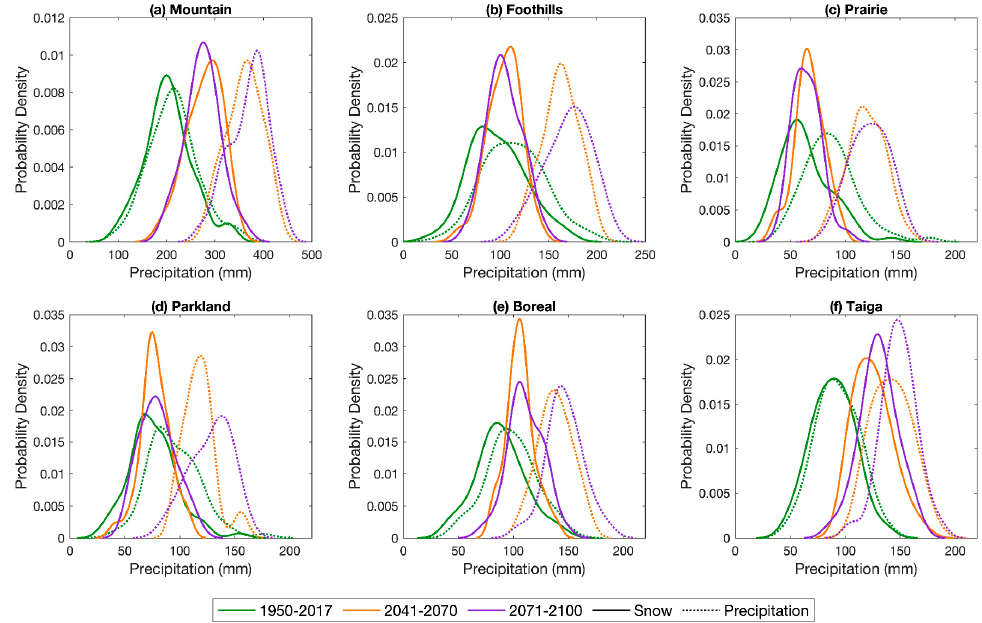
Figure 11. Probability density function of total November–April snowfall (solid lines) and precipitation (dotted lines) amounts for historic and projected future periods under RCP 4.5.